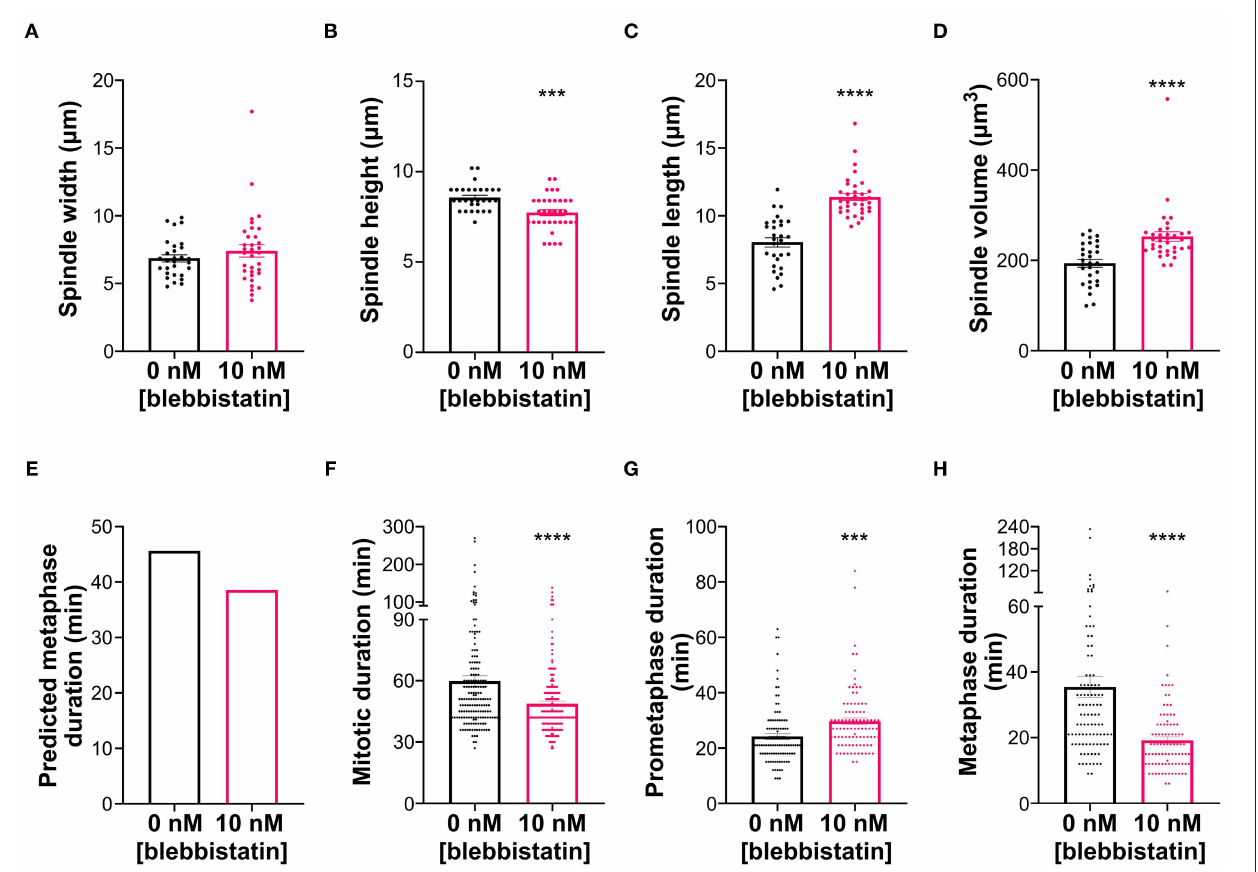
FIGURE 7 | Blebbistatin treatment modifies spindle dimensions and reduces metaphase duration in S1 cells. (A–D) Measurements of mitotic spindle width (A) , height (B) , length (C) , and volume (D) in untreated and blebbistatin-treated S1 cells ( n 29 and 36, respectively), reported as mean SEM with individual data points from = ± three independent experiments. *** p < 0.001, **** p < 0.0001, when compared to untreated cells by Student’s t -test. (E) Model-predicted metaphase duration using the median spindle dimensions in panels (A–C) . Cell size, spindle pole size, and spindle microtubule abundance were assumed to be the same between the control and treated groups. (F–H) Quantification of (F) mitotic duration in untreated and blebbistatin-treated S1 cells ( n 167 and 193, respectively), (G) prometaphase = duration in untreated and blebbistatin-treated S1 cells ( n 101 and 92, respectively), and (H) metaphase duration in untreated and blebbistatin-treated S1 cells = ( n 101 and 94, respectively). *** p < 0.001, **** p < 0.0001, when compared to untreated cells by Student’s t =